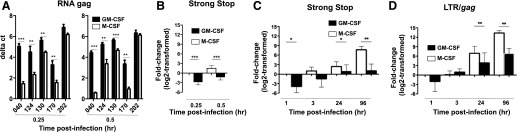
HIV-1 entry and replication is significantly decreased in GM-CSF–derived, compared with M-CSF–derived, MDMs.GM-CSF– or M-CSF–derived MDMs (filled or open bars), were infected with BaL (A and B) or US-1 (C and D). (A) RNA from the lysates at 0.25 and 0.5 h postinfection was subjected to qRT-PCR for HIV-1 gag RNA (virus entry). ΔCt values for HIV gag RNA was normalized to GAPDH RNA. A lower ΔCt value indicates a higher amount of viral RNA or higher viral entry. Lysates collected at 0.25, 0.5, 1, 3, 24, and 96 h postinfection were analyzed for early strong stop or late LTR-gag DNA reverse transcripts indicative of virus entry (B, C) or replication (D). GAPDH-normalized target levels are displayed relative to the corresponding 0.25 h sample for (B) or to 1 h samples (C and D) of M-CSF differentiated MDM as mean log2-transformed fold-change ± S.D. for either 3 or 2 iterations of 3 or 2 independent experiments (B). (*P = 0.01; **P = 0.001; ***P = 0.0001; 2-tailed paired t tests).